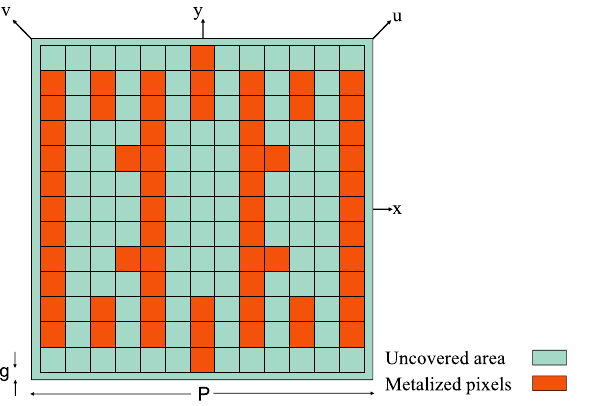
Figure 7. Schematic of the optimized polarization converter unit cell.